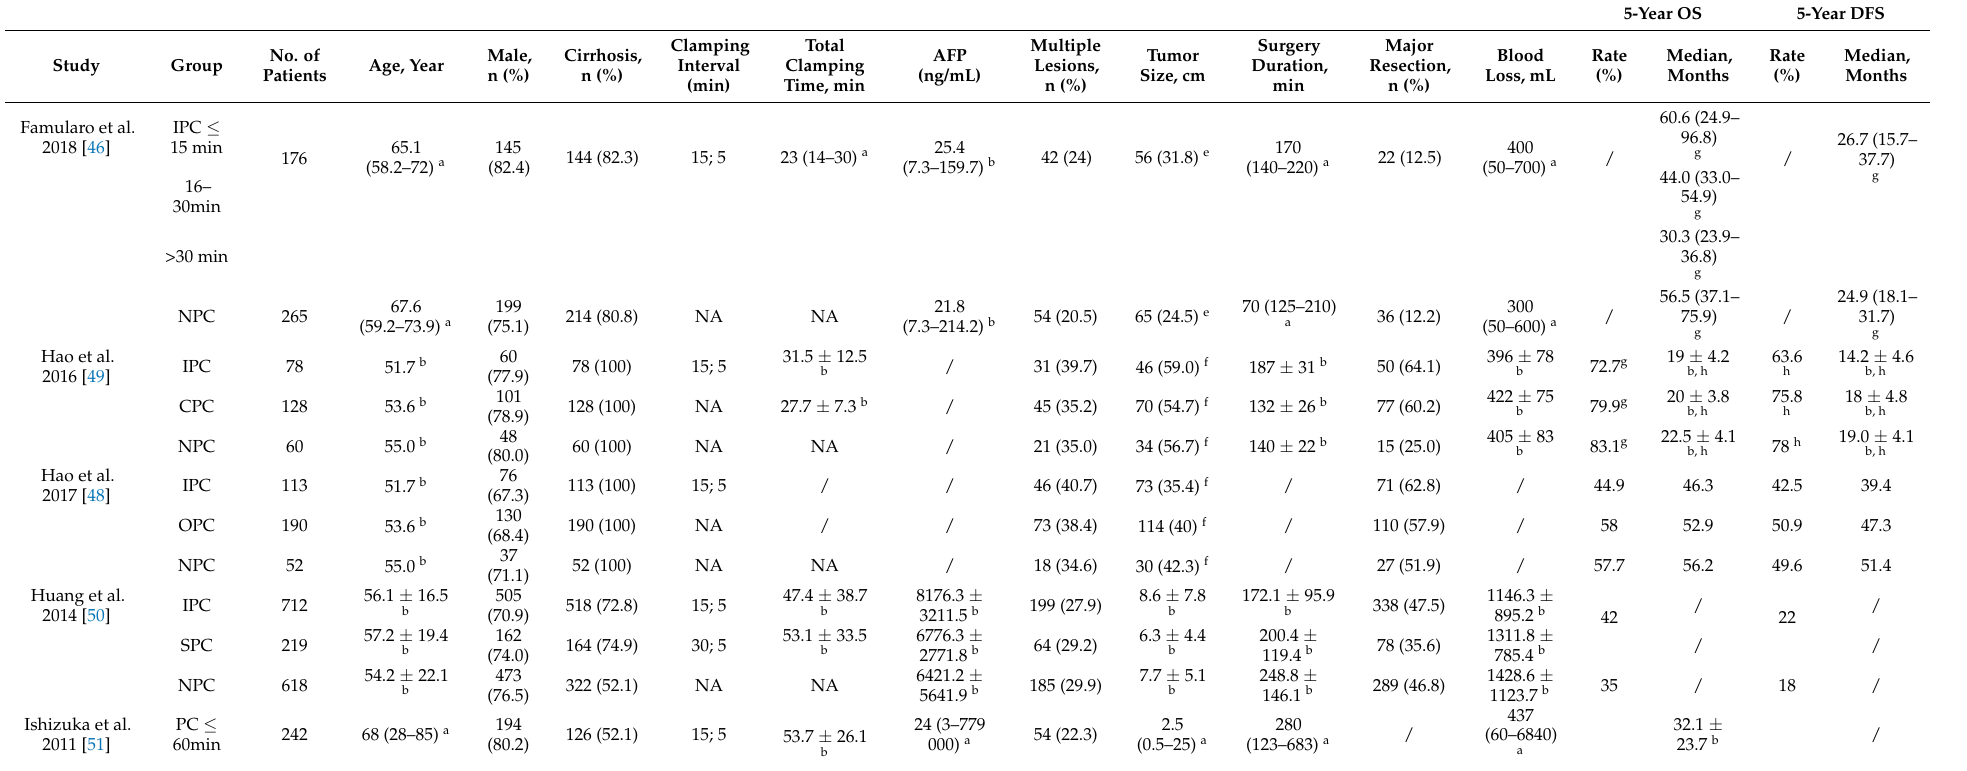
Table 2. Patient, tumor and treatment characteristics according to clamping